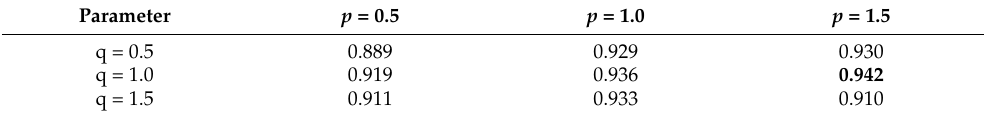
Table 3. Experimental results for different parameter settings on Facebook dataset. Parameter